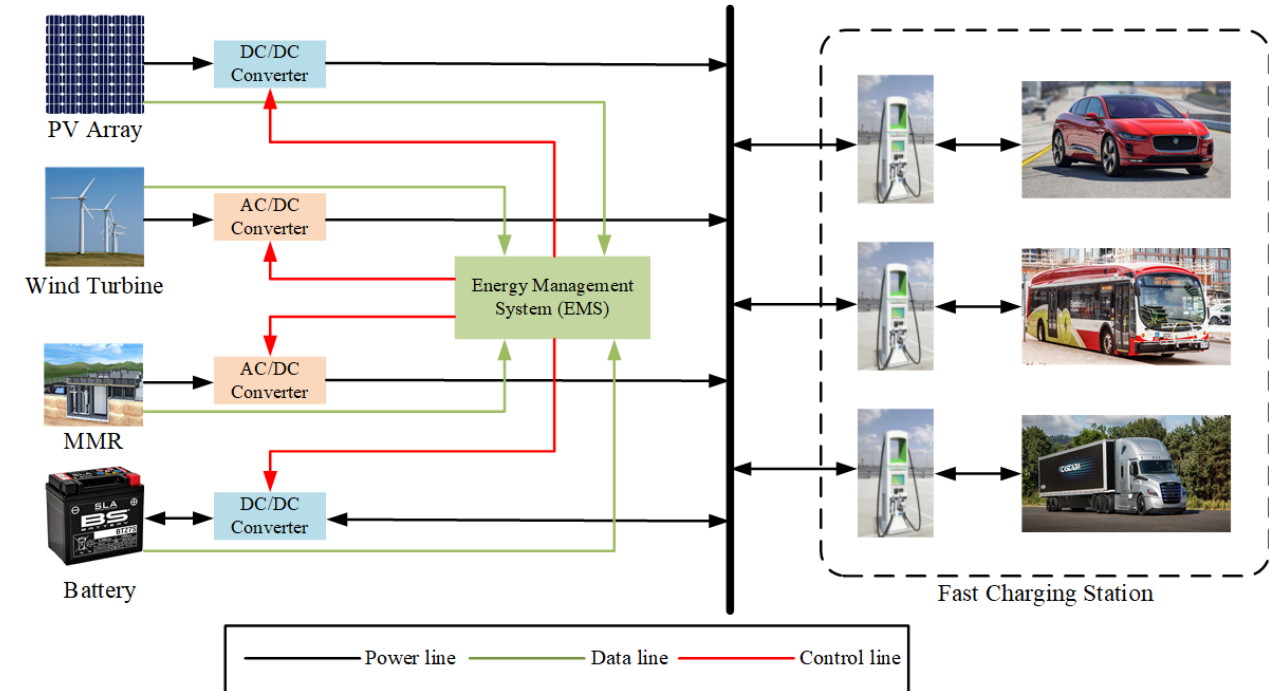
Figure 1. Proposed N-R HES illustration for fast charging